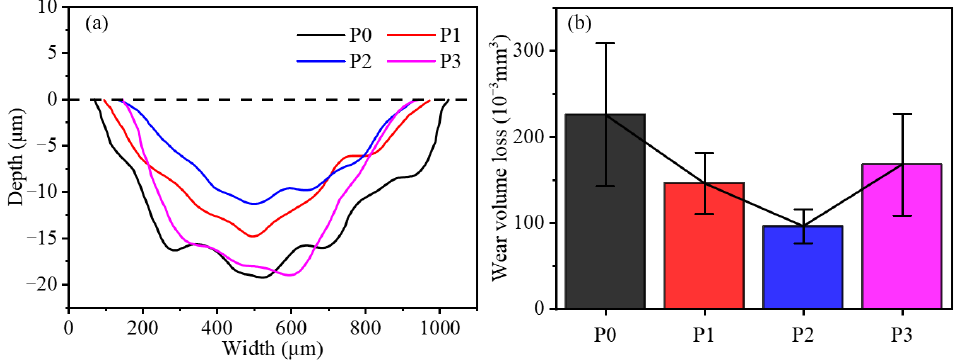
Figure 12. The effect of ultrasonic vibration power on wear of laser cladding ceramic coatings: ( a ) wear track profile, ( b ) wear volume loss.